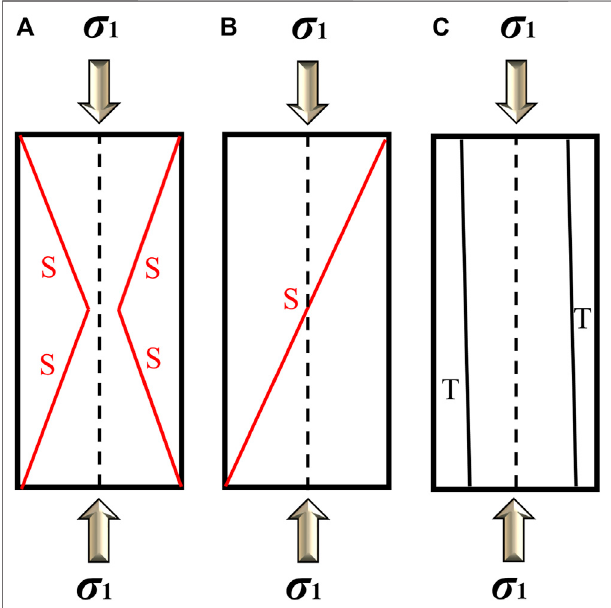
FIGURE 10 | Uniaxial compression test force and failure modes of specimens: (A) X-shaped conjugate inclined plane shear failure mode; (B) Single inclined plane shear failure mode; (C) Tensile failure mode (Zhang and Zhou., 2020b; Zhao et al.,